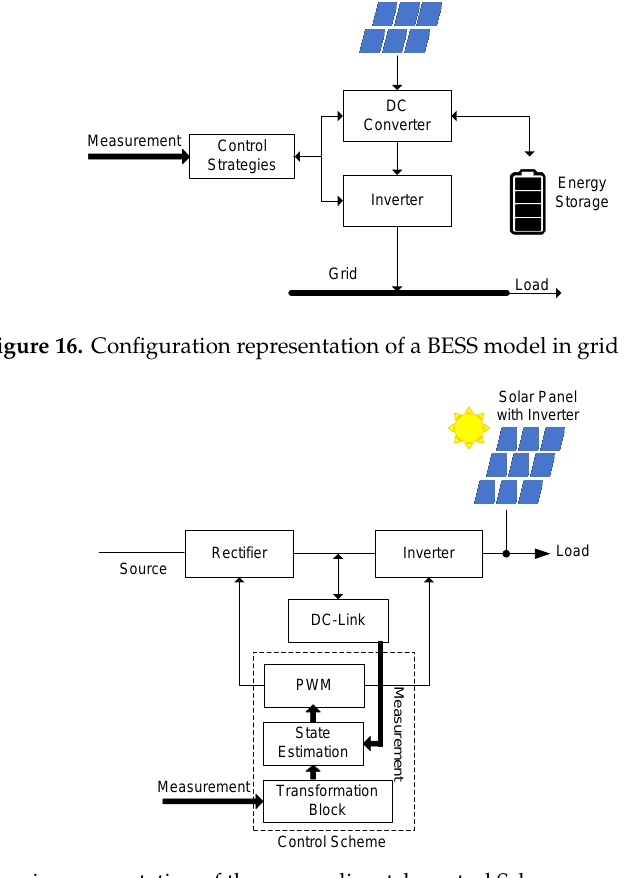
Figure 17. A generic representation of the power dispatch control Scheme on a grid-feeding topology.